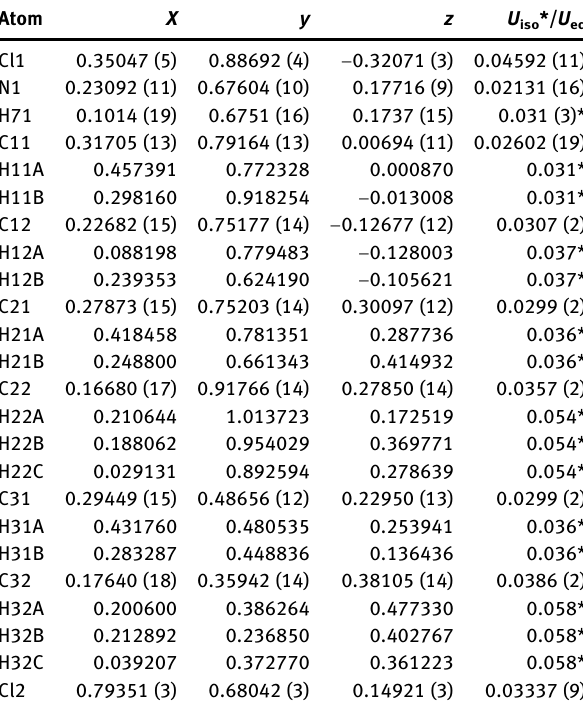
for these contacts is DDD at the unitary level. In total, the entities of the title compound are connected to chains along the crystallographic a axis.